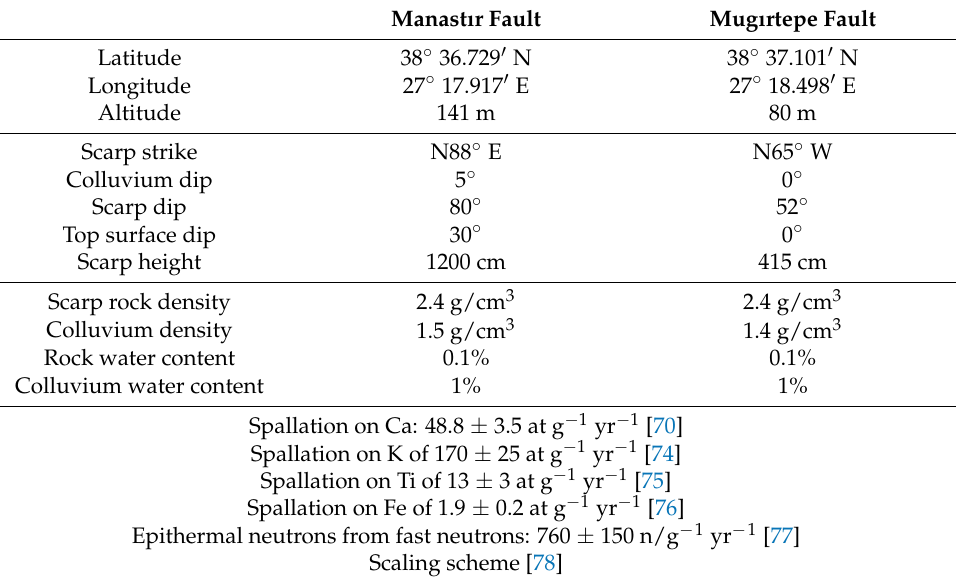
Table 1. Input parameters of the Manastır and Mugırtepe fault scarps for earthquake